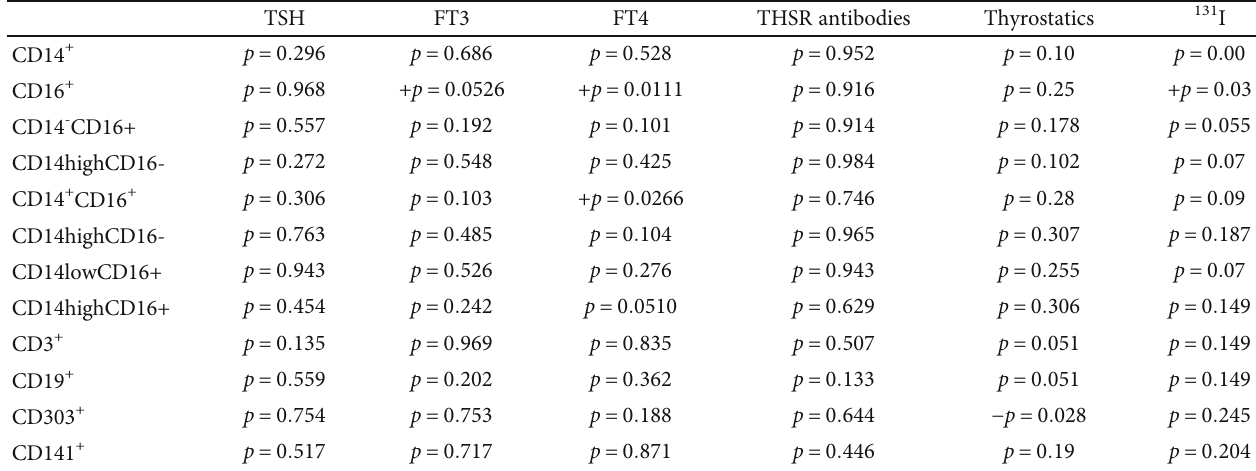
Table 2: The results of the Spearman rank-order correlation analysis. The pairs of variables with positive correlation coe ffi cients and p values below 0.050 tend to increase together. For the pair with negative correlation coe ffi cients and p values below 0.050, one variable tends to decrease while the other increases. For pairs with p values greater than 0.050, there is no signi fi cant relation between the two variables.